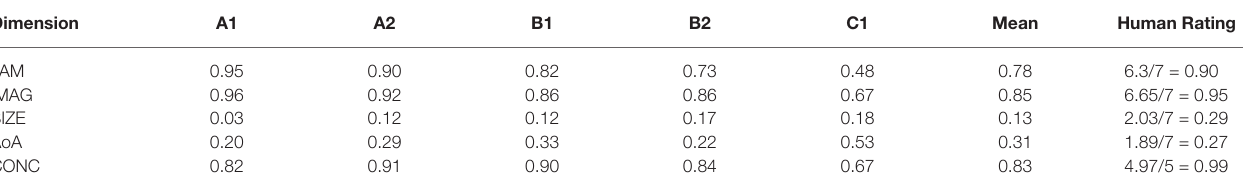
TABLE 2 | Sample LPP dimension scores computed by the algorithm for the word egg in the five EFCAMDAT2 sub-corpora. Dimension